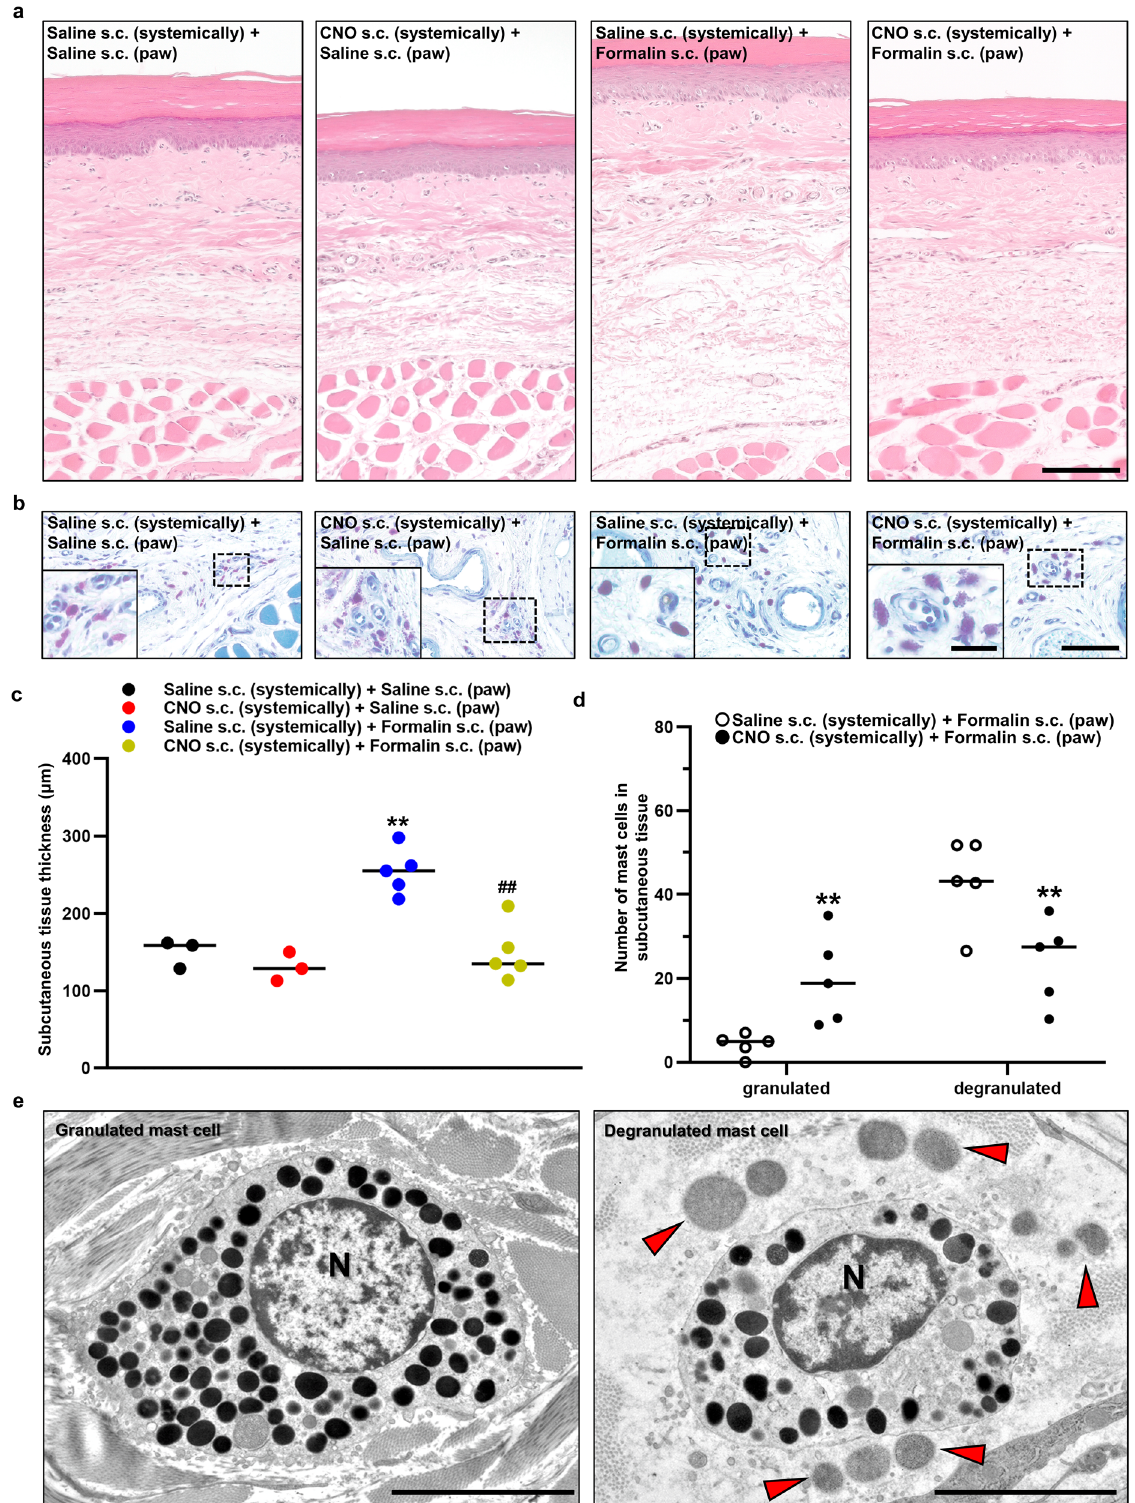
Fig. 8 OT exerted an anti-in fl ammatory response by inhibiting mast cell degranulation. Morphology of hematoxylin and eosin (HE)-stained ( a ) and toluidine blue (TB)-stained ( b ) hind paw after the s.c. injection of saline or 5% formalin (100 µ L) into the hind paw. Scale bar in (A), 50 µ m. Scale bar in (B), 10 µ m and 5 µ m (in magni fi ed image). c The subcutaneous tissue thickness measured using the HE-stained hind paw slices ( n = 6 – 10 slices from 3 to 5 rats, each). ** P < 0.01 vs. Saline s.c. + Saline s.c. ## P < 0.01 vs. Saline s.c. + Formalin s.c. d Number of mast cells in subcutaneous tissue either granulated or degranulated was manually counted ( n = 10 slices from 5 rats, each). ** P < 0.01 vs. Saline s.c. + Formalin s.c. e Granulated and degranulated mast cell captured by transmission electron microscope (TEM) after formalin injection. N, nucleus. Red arrow heads indicate the granules that were degranulated from a mast cell. Scale bars, 5 µ m. See also Supplementary Fig.